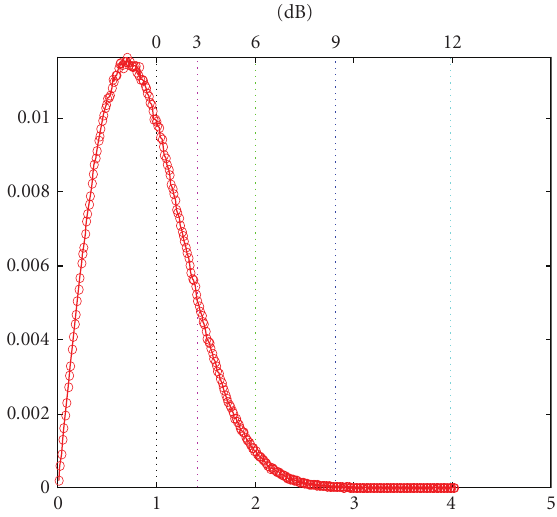
Figure 2: Amplitude histogram of a 256 subcarrier OFDM